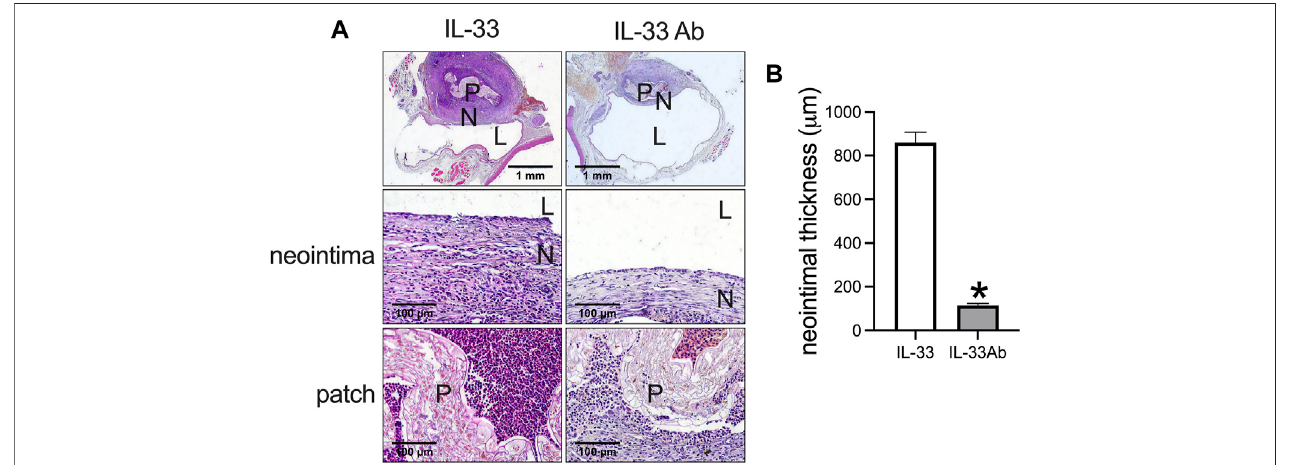
FIGURE 5 | IL-33-absorbed plant leaf increased venous hyperplasia while IL-33 antibody (IL-33 Ab)-absorbed plant leaf decreased venous hyperplasia in the rat inferior vena cava (IVC) venoplasty model. (A) First row, photographs of hematoxylin and eosin (H&E) staining showing the IL-33 and IL-33 Ab-absorbed plant patch harvested at day 14; second row, high power showing the neointima; third row, high power showing the patch; P, patch; N, neointima; L, lumen; scale bar, 1 mm and 100 μ m. (B) Bar graphs showing the neointimal thickness (*, p (cid:2) 0.0001, t-test), n (cid:2) 3.